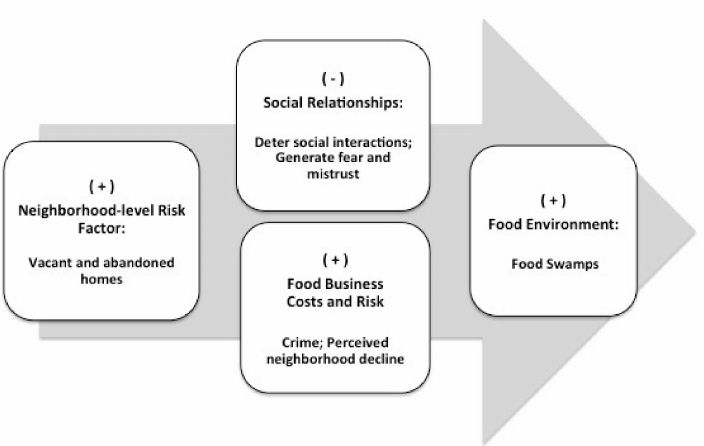
Figure 1. Simplified conceptual framework of proposed relationships between vacant and abandoned homes (proxy of neighborhood-level risk factor), social relationships among community members, decisions of food outlet owners related to business costs and perceived risk, and food swamps in Baltimore, MD, USA. A positive relationship is represented by ‘+’, and a negative relationship is represented by ‘ − ‘ (i.e., increases in neighborhood-level risk factors negatively impact social relationships, increases food business costs and perceived risk, and contributes to food